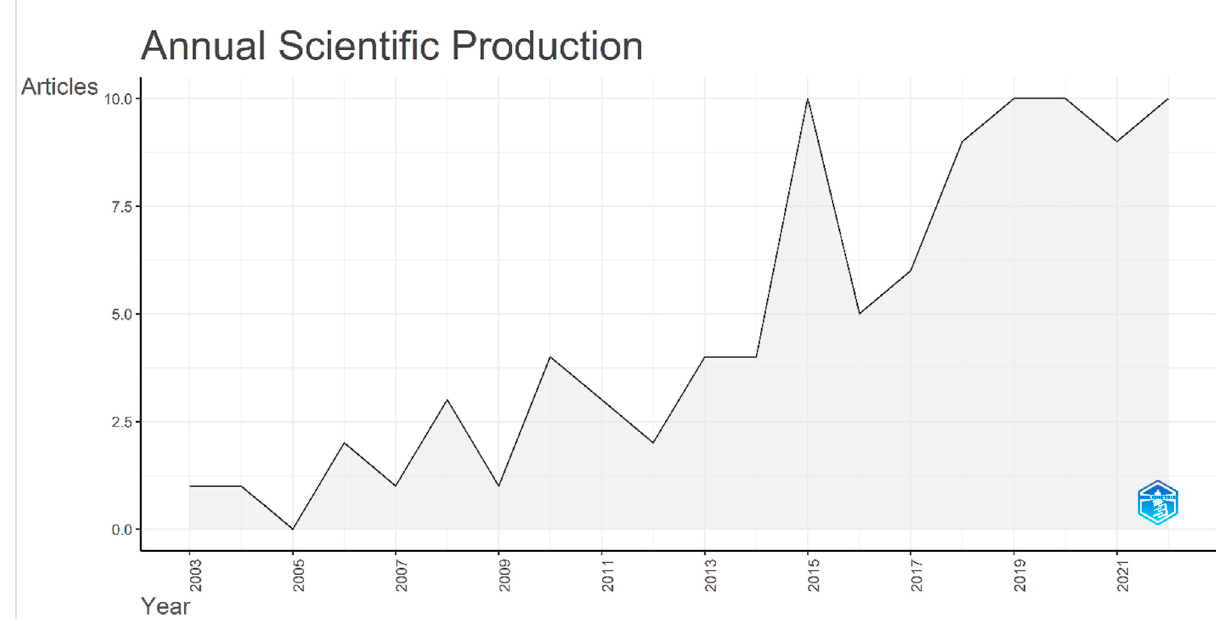
FIGURE 8 TotalnumberofpublicationsontheCIPKgenefamilyoverthestudyperiod.The x -axisindicatestheyearswhilethe y -axisindicatesthenumber of